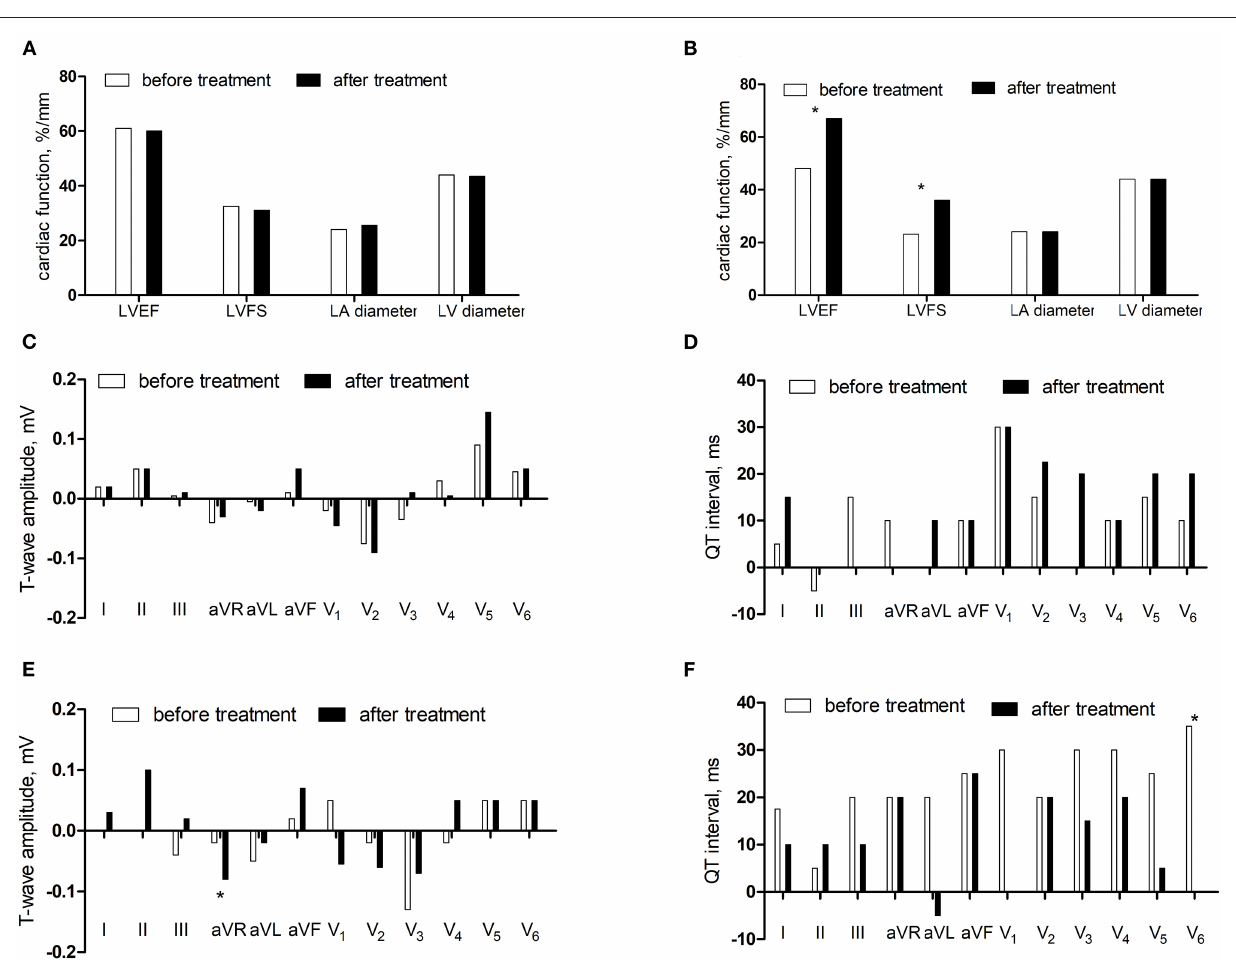
FIGURE 5 | The comparisons before and after treatment. (A) The cardiac function in the non-response group. (B) The cardiac function in the response group. (C) The differences of T-wave amplitude in the non-response group. (D) The differences of QT interval in the non-response group. (E) The differences of T-wave amplitude in the response group. (F) The differences of QT interval in the response group.* P <